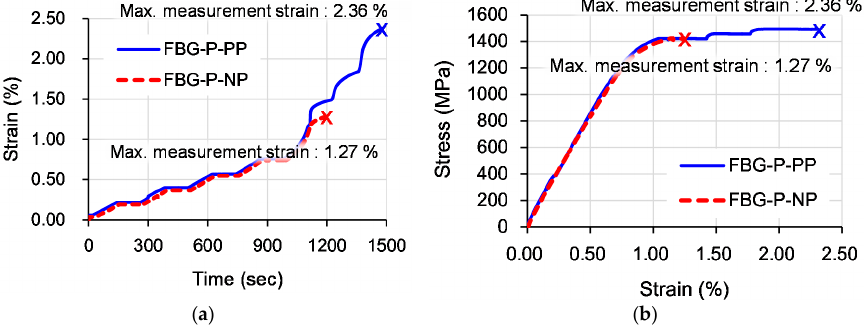
Figure 13. Representative test results: ( a ) tensile strain and time curves; ( b ) tensile stress and strain curves.